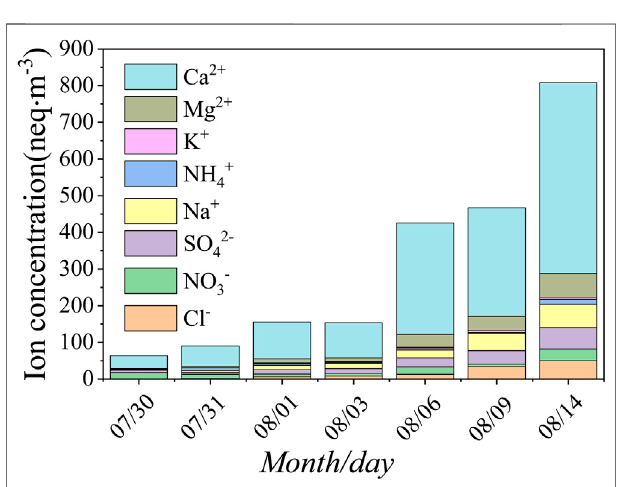
FIGURE 2 | Temporal variation in the concentration of soluble ions in aerosol samples in 2008.